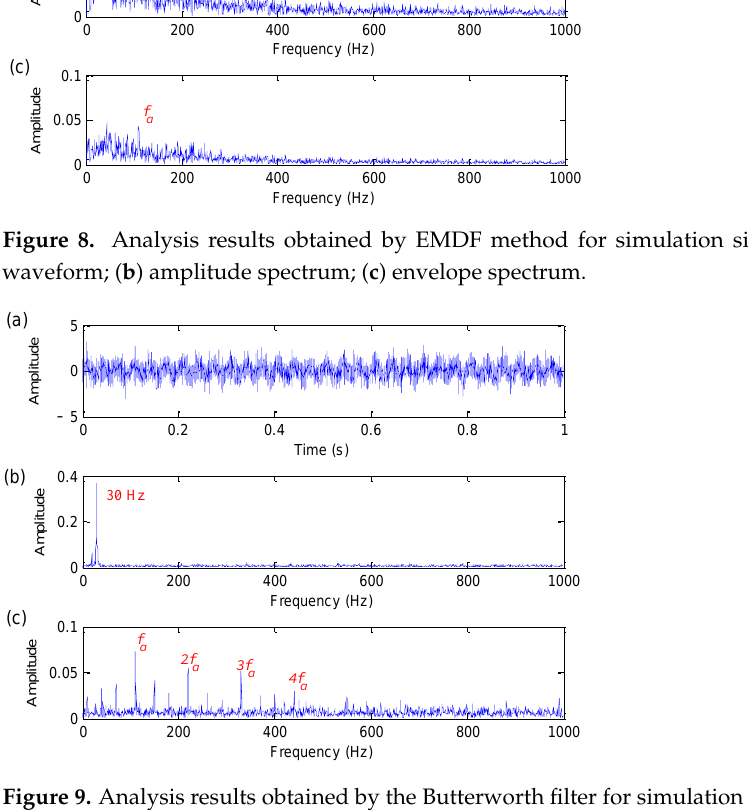
Figure 9. Analysis results obtained by the Butterworth filter for simulation signal: ( a ) Time domain waveform; ( b ) amplitude spectrum; ( c ) envelope spectrum.